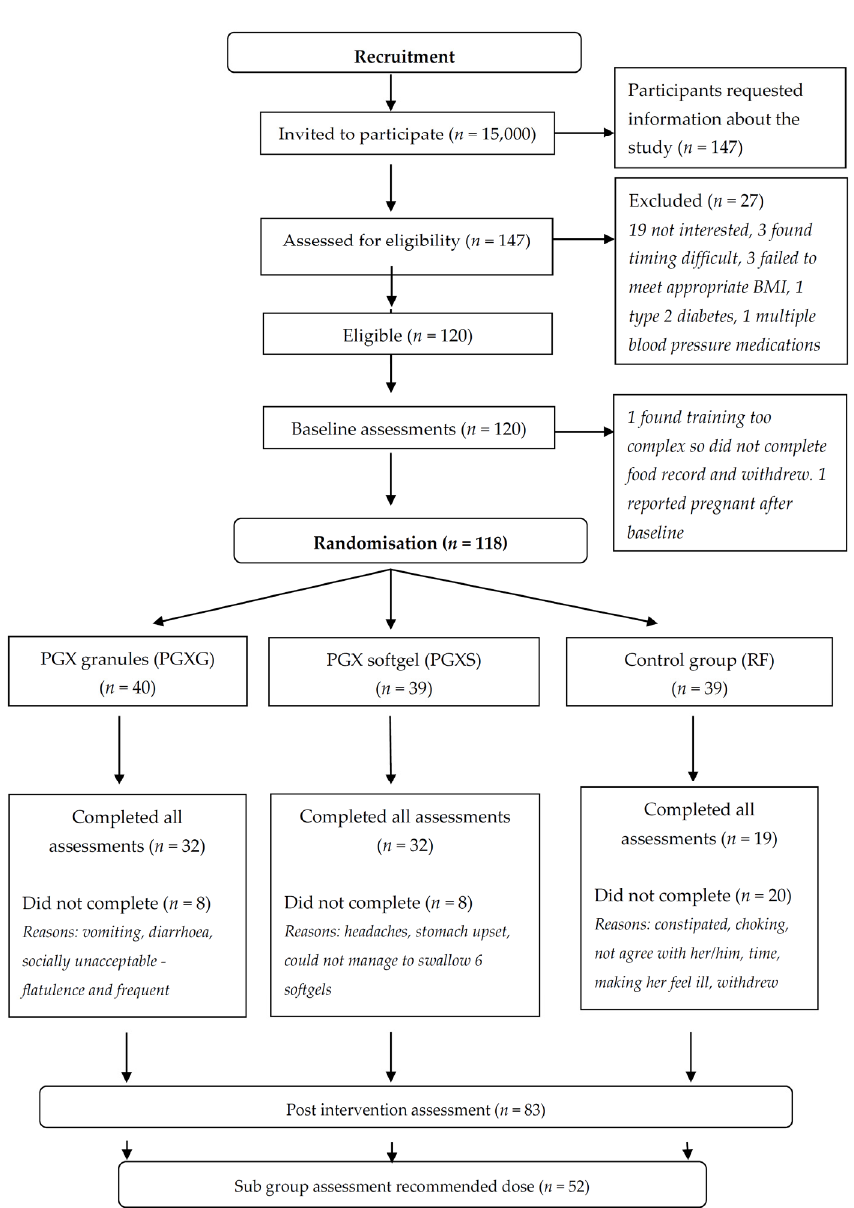
Figure 1. Participant flow diagram. RF: rice flour.